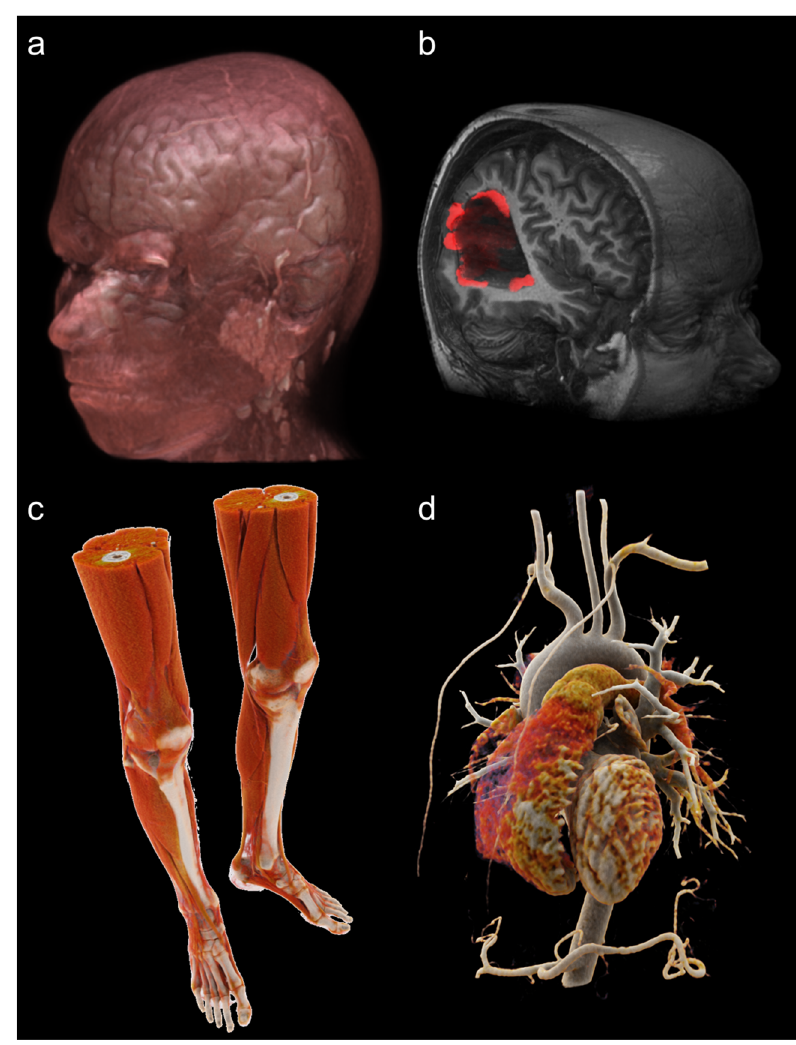
Fig. 8 Current possibility for 3D